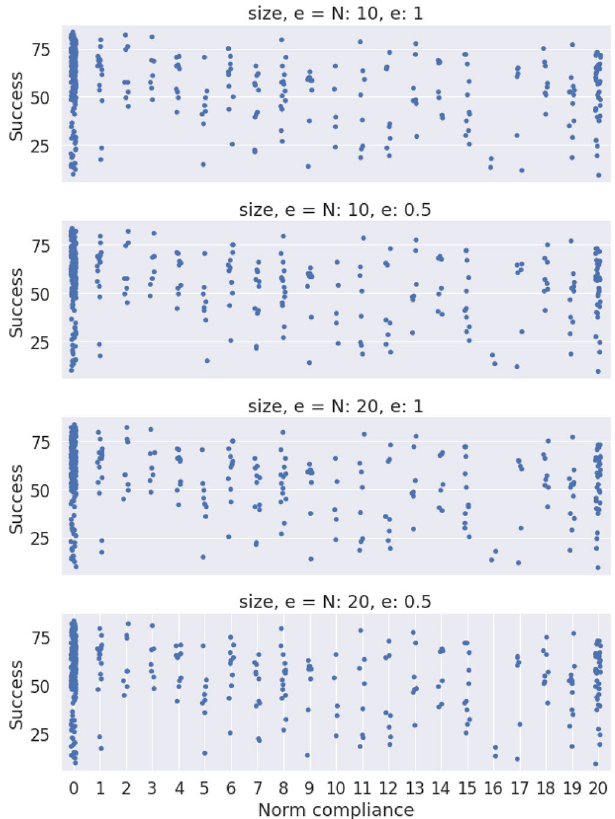
Figure 6. Relation between the binary coordination game and the degree of norm compliance (measured from 0 to 20). On the X axis, the degree of norm compliance; on the Y axis, the number of coordinations for a player during the